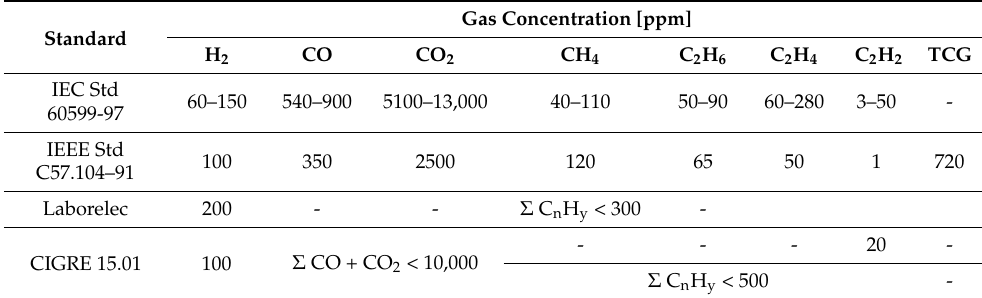
Table 15. Limits for the concentration of gases dissolved in oil. Adapted from [59], licensed under CC BY